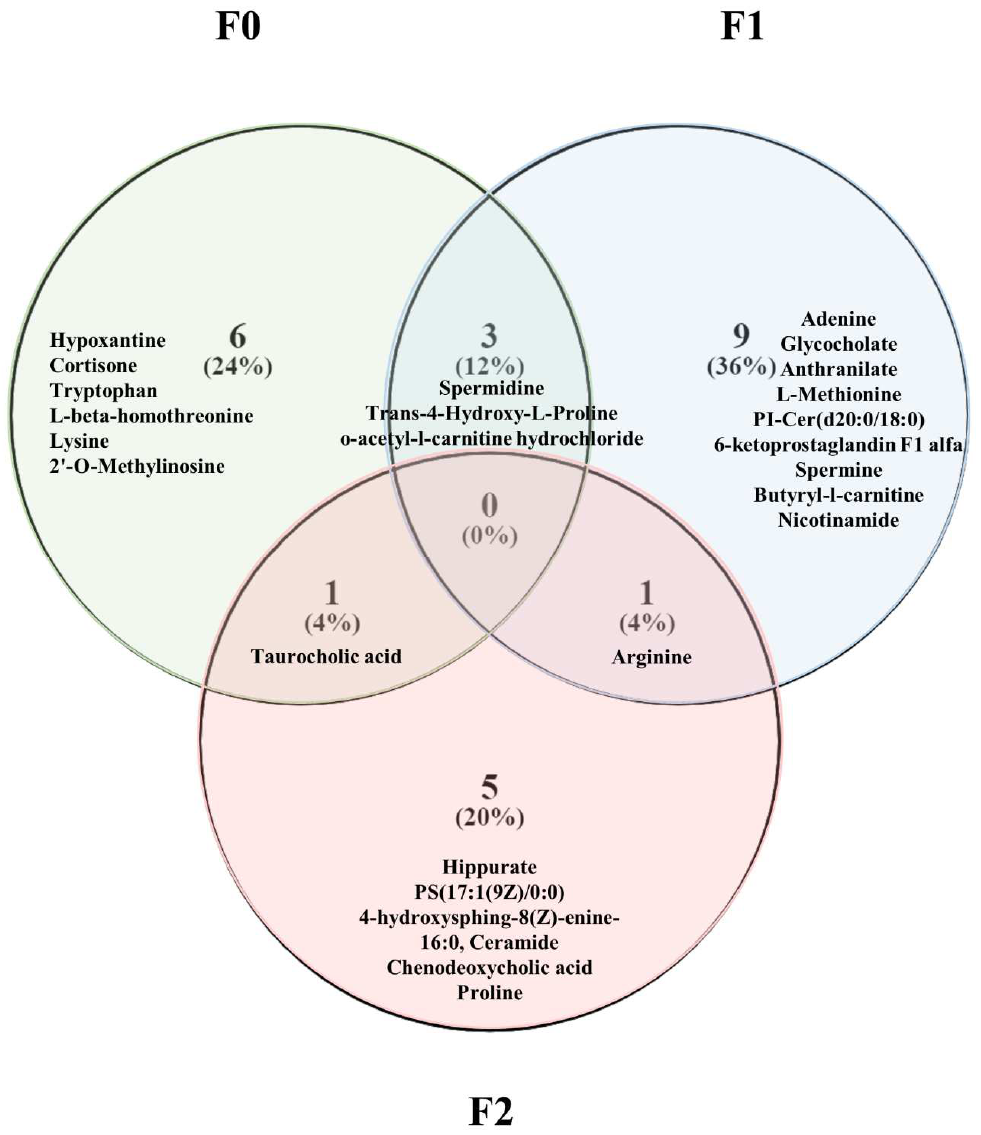
Figure 5. Number (percentage) and name of the most discriminant metabolites identified in spermatozoa samples from each generation used in PLS-DA models.